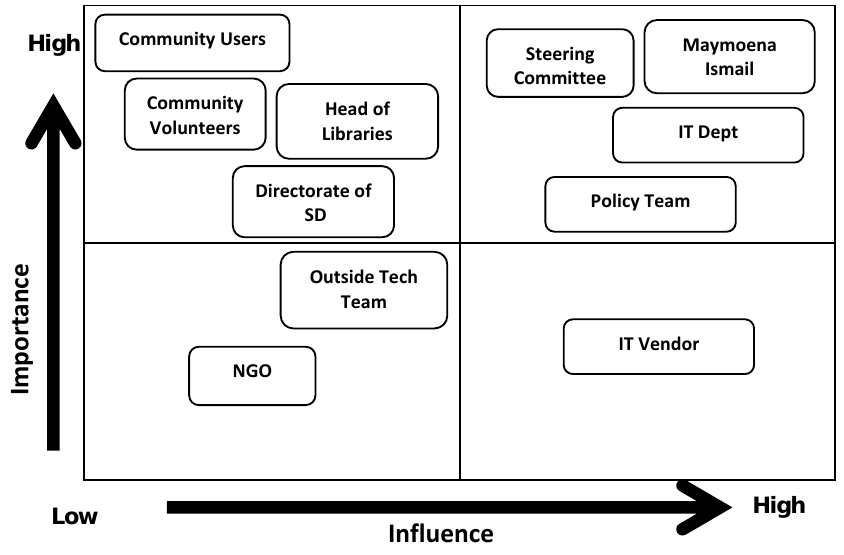
Figure 4: The stakeholder importance influence